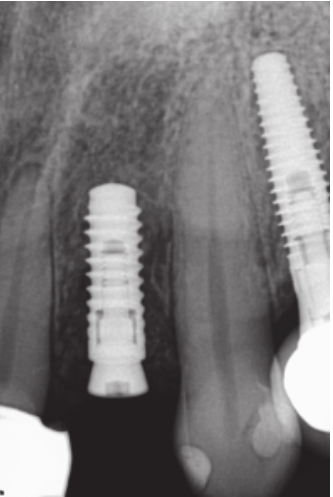
Figure 8: Following the treatment of implant site with EDTA, FDBA, and Emdogain (cid:2) .